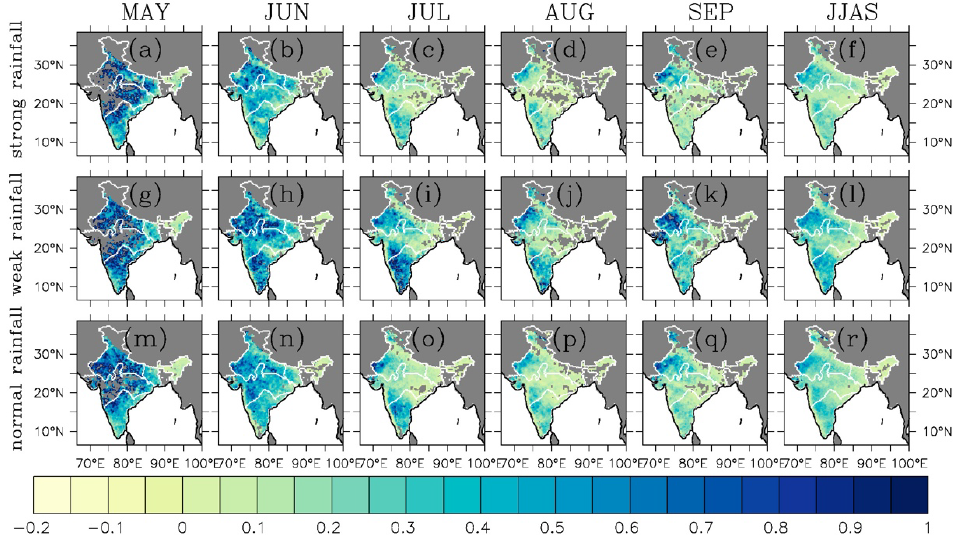
Figure 9. Spatial distribution of slope in India based on a linear regression analysis for daily SM regressed on daily rainfall for May through September and JJAS during strong ISMs ( top row , ( a – f )), weak ISMs ( second row , ( g – l )), and normal ISMs ( bottom row , ( m – r )). The slope at each grid is computed based on the linear regression analysis (i.e., SM = slope × rainfall + intercept). The slope is shown only when it is statistically significant at the 95% confidence level. Note that slope values have been multiplied by 100.